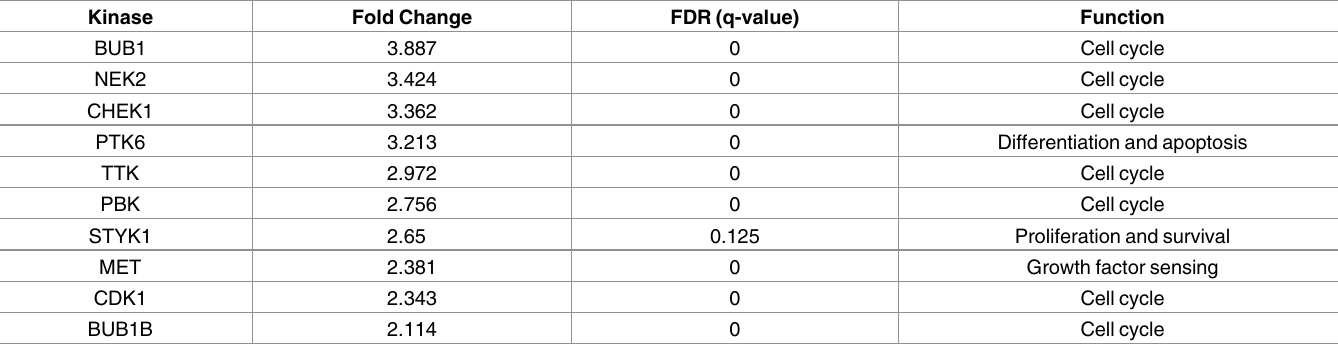
Table 2. Function of the 10 most overexpressed